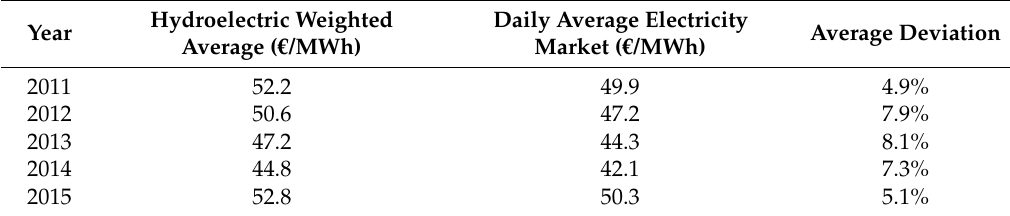
Table 6. Alignment ratio for hydroelectric power stations. Own elaboration based on data from The Spanish Electricity